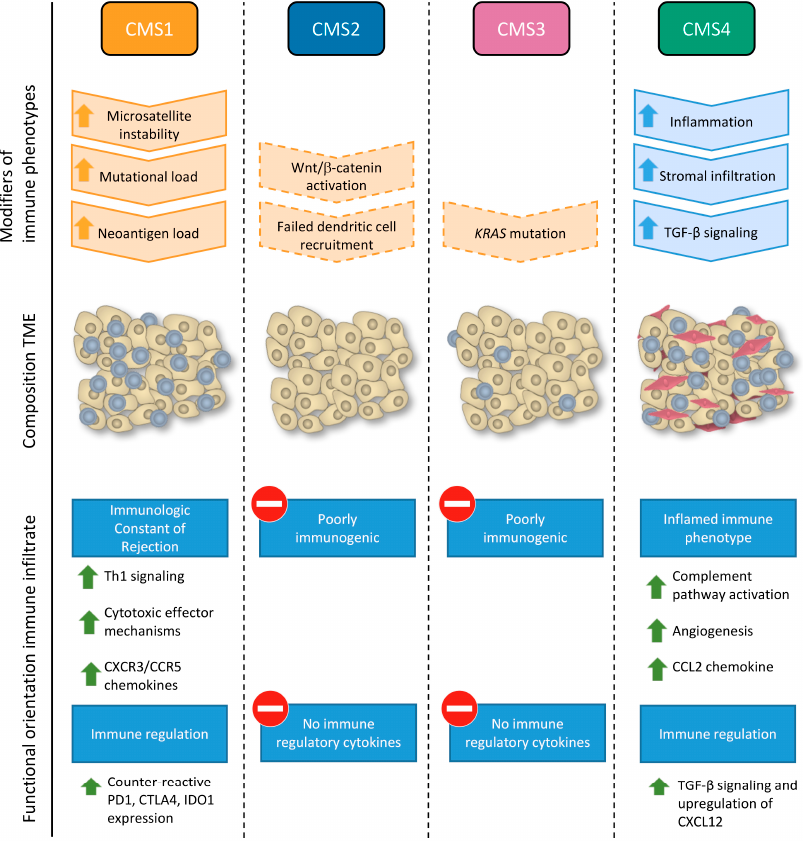
Figure 2. Intratumoral immune phenotypes associate with consensus molecular subtypes (CMS) of colorectal cancer. The transcription- and mutational profiles of consensus molecular subtypes are associated with characteristic intratumoral immune phenotypes. Proposed modifiers of the immune phenotype, either genetic (in orange) or environmental (in blue), supported by experimental evidence in colorectal cancer (solid borders) or supported by evidence in other cancer types (dashed borders) are shown. Both CMS1 and CMS4 tumor microenvironments (TME) are characterized by high levels of TILs (blue), while CMS4 is also infiltrated with cancer-associated fibroblasts (red). CMS1 and CMS4 display divergent functional orientations of their immune infiltrate: while CMS1 tumors display a favorable orientation defined by expression of Immunologic Constant of Rejection (ICR) genes, associated with counter-active upregulation of immune checkpoint molecules; CMS4 tumors have an unfavorable, inflamed immune phenotype, characterized by transforming growth factor beta (TGF- β ) signaling, complement activation and increased angiogenesis. CMS2 and CMS3 are both poorly immunogenic characterized by exclusion of TILs from the tumor site and minimal expression of immune-related transcripts. CXCR3/CCR5: Chemokine (C-X-C motif) receptor 3/C-C chemokine receptor type